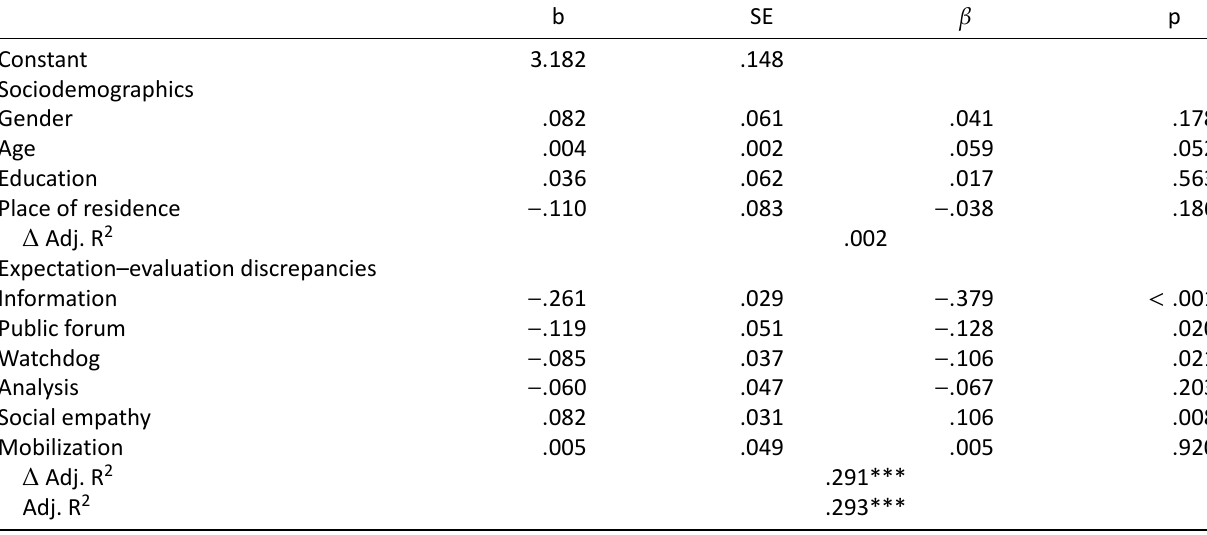
Table 3. Linear regression model of the relationship between expectation–evaluation discrepancies and media